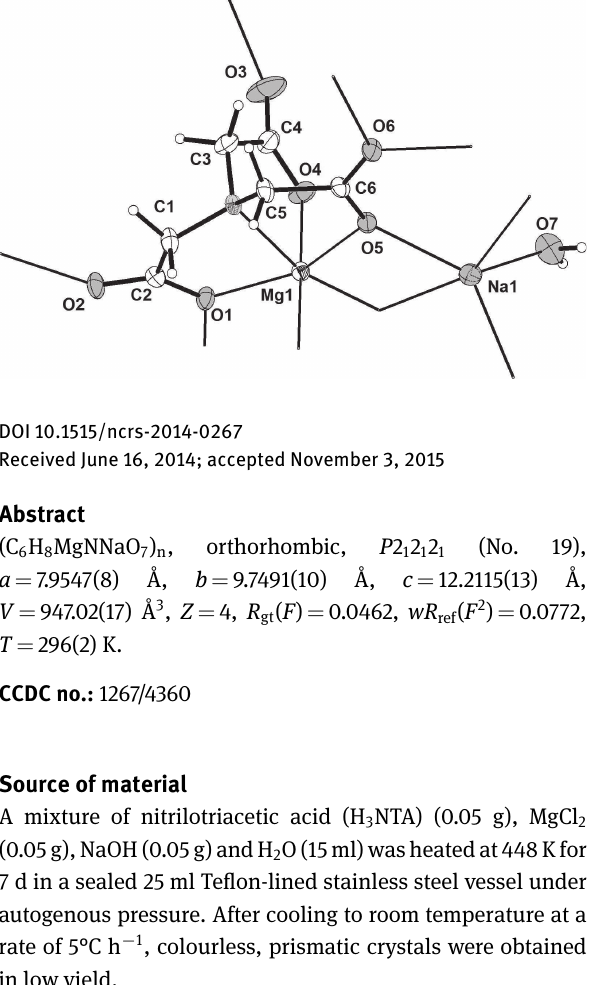
Table 1: Data collection and handling.